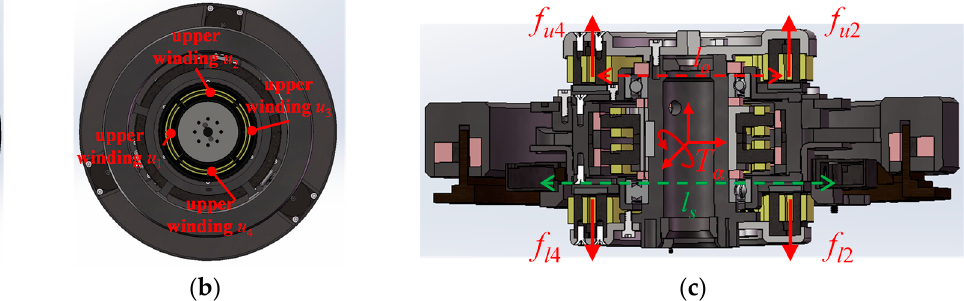
Figure 2. The structure and force models of the 2 − DoF radial AMB. ( a ) The top view of the 2 − DoF radial AMB; ( b ) the force distributions of the 2 − DoF radial AMB.